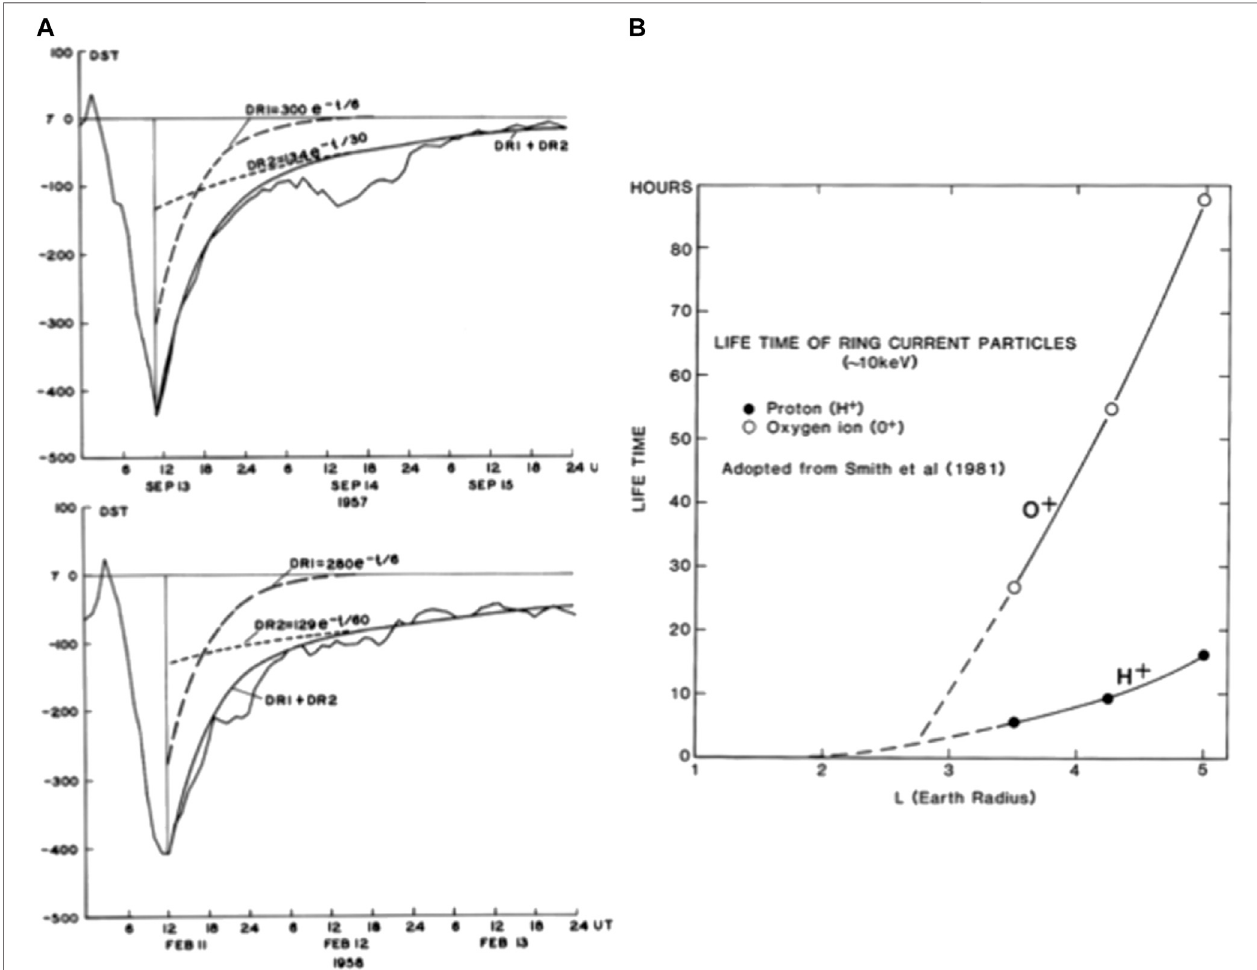
FIGURE 17 | (A) It was proposed that the ring current consists of two belts, DR1 and DR2 with two different decay rates; Akasofu et al. (1963). (B) An attempt to explain the recovery phase by considering protons and oxygen ions, assuming the life time of protons and oxygen ions. storm.